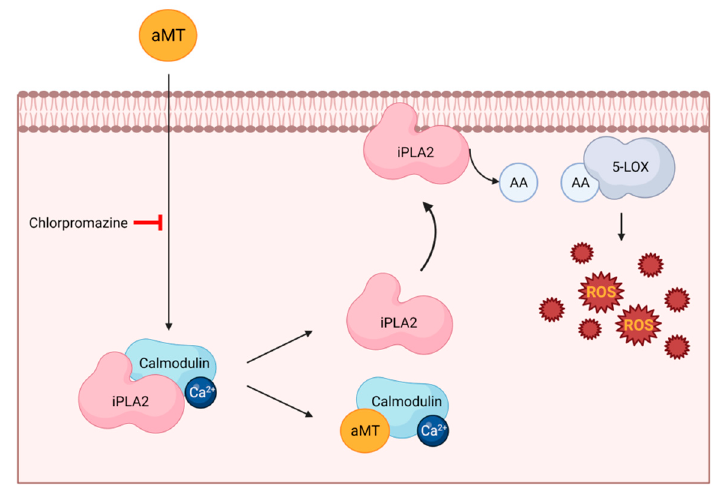
Figure 1. Melatonin induces ROS production in cancer cells through calmodulin binding. Melatonin binds to calmodulin, leading to the release of sequestered Ca 2+ -independent PLA2, which is then free to move to membranes and to release high doses of AA; in turn, liberated AA feeds 5-LOX to produce free radicals. Melatonin (aMT); Ca 2+ -independent PLA2 (iPLA2); arachidonic acid (AA); 5- lipoxygenase (5-LOX). Image created using BioRender.com (accessed on 18 August 2022).